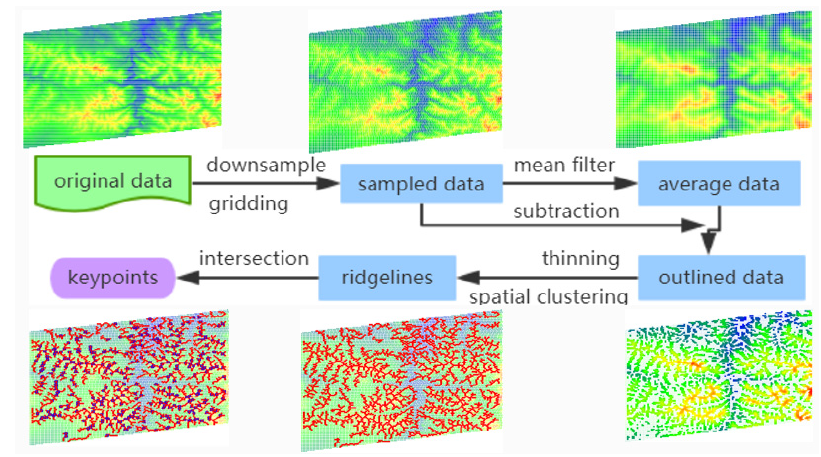
Figure 3. Ridgeline-based keypoint extraction.